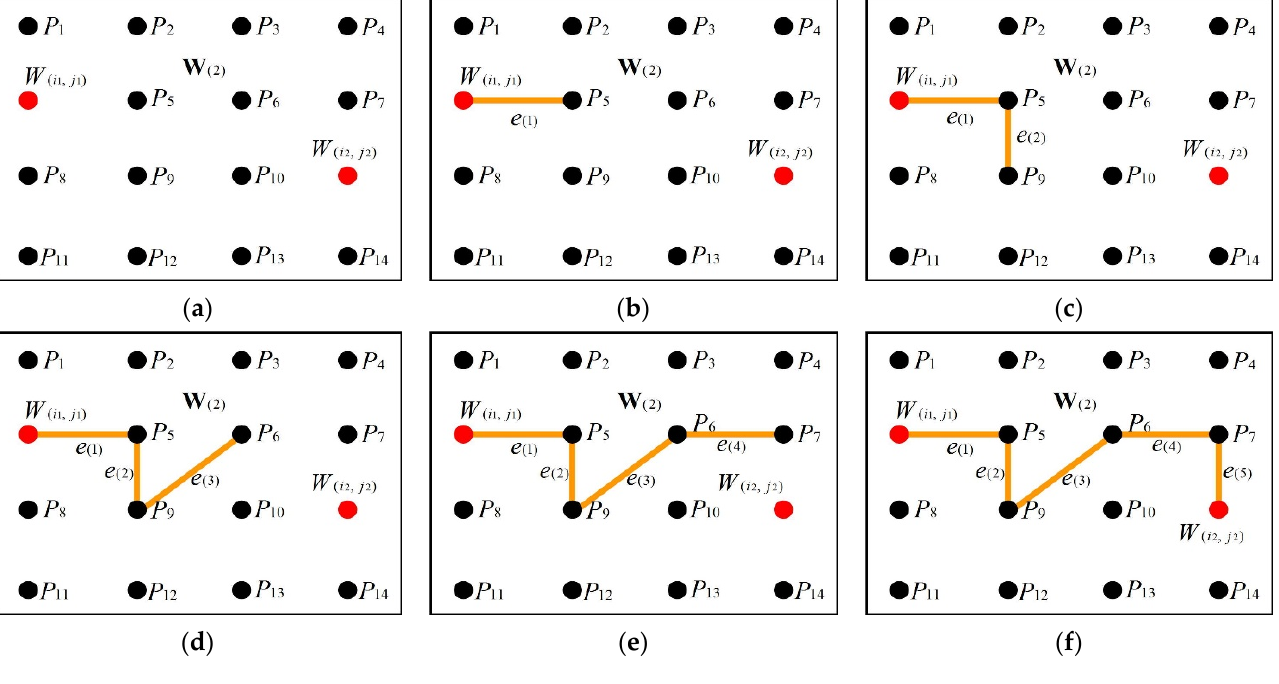
Figure 3. The process of searching and building the structure tree T ( 1 ) . ( a ) shows the initial state of the algorithm. ( b ) shows the searching process of P 5 and e (1) . ( c ) shows the searching process of P 9 and e (2) . ( d ) shows the searching process of P 6 and e (3) . ( e ) shows the searching process of P 7 and e (4) . ( f ) shows the searching process of W ( i and e (5) . 2 , j 2 )